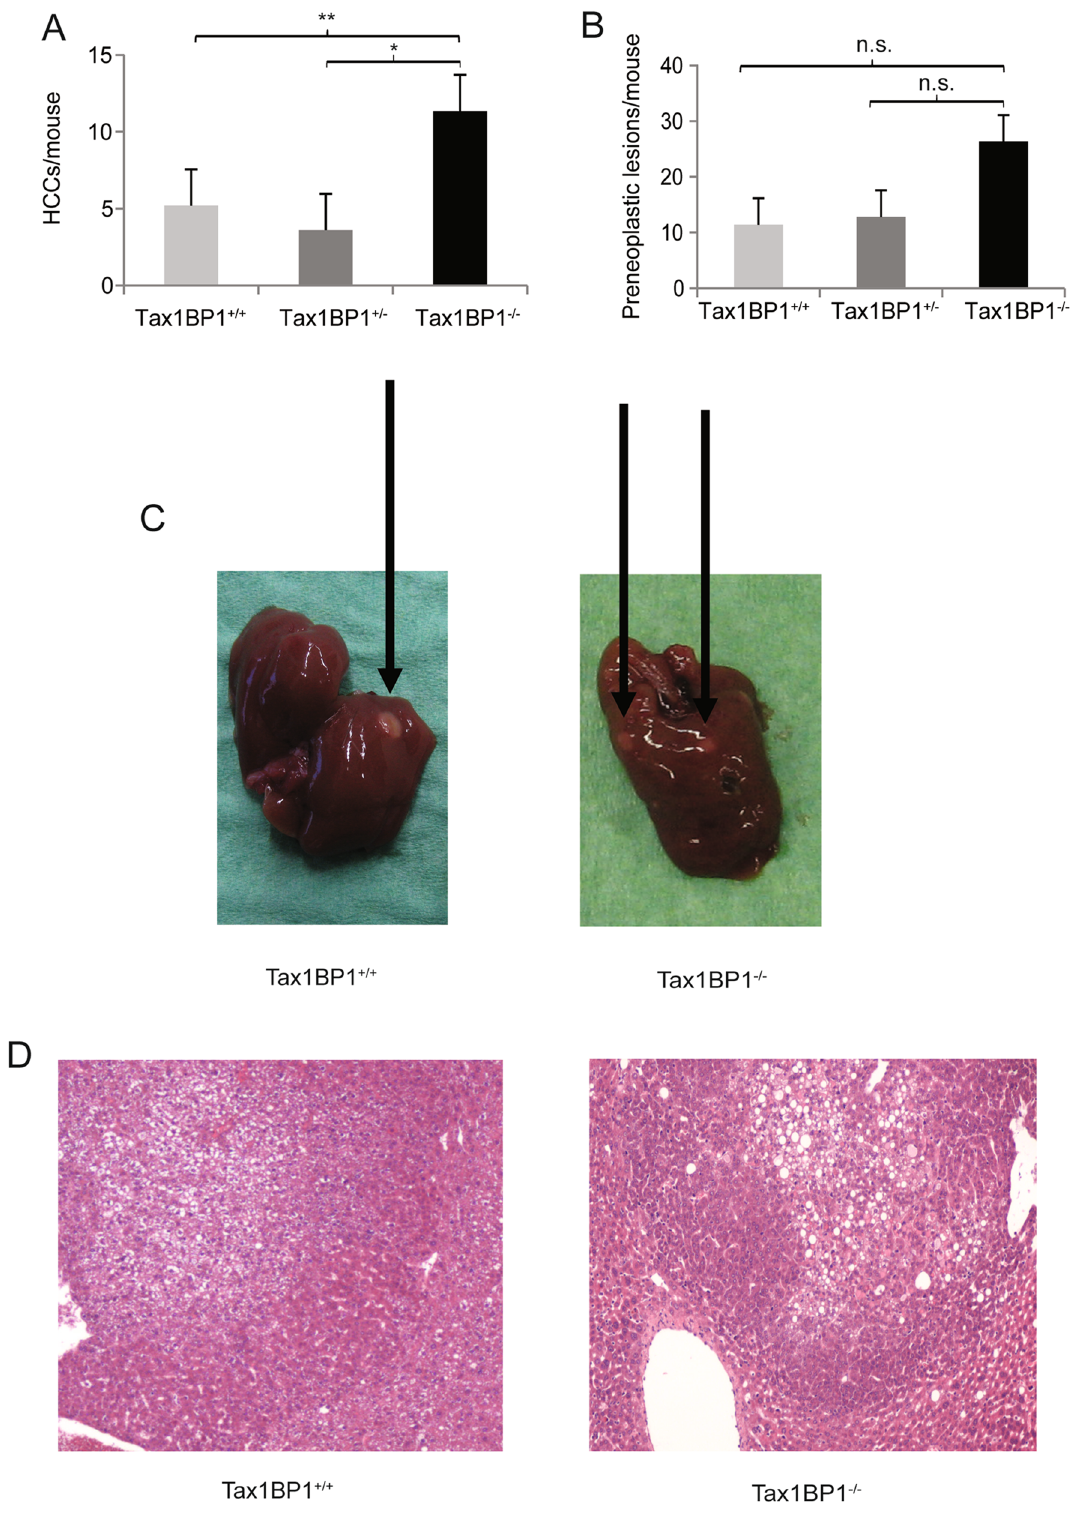
Figure 5. Liver tumor development. Number of hepatocellular carcinomas ( A ) and pre-neoplastic tumors ( B ) in male Tax1BP1 +/+ (n = 5), Tax1BP1 +/− (n = 5) and Tax1BP1 −/− (n = 3) mice after DEN treatment are shown in bar graphs. Differences in the number of tumors between different strains were determined using the nonparametric Kruskal–Wallis test * P < 0.05; ** P < 0.01; n.s. not significant). Representative macroscopic livers ( C ) and representative histological hematoxylin and eosin stained tumor slides ( D ) from Tax1BP1 +/+ and Tax1BP1 −/− mice are